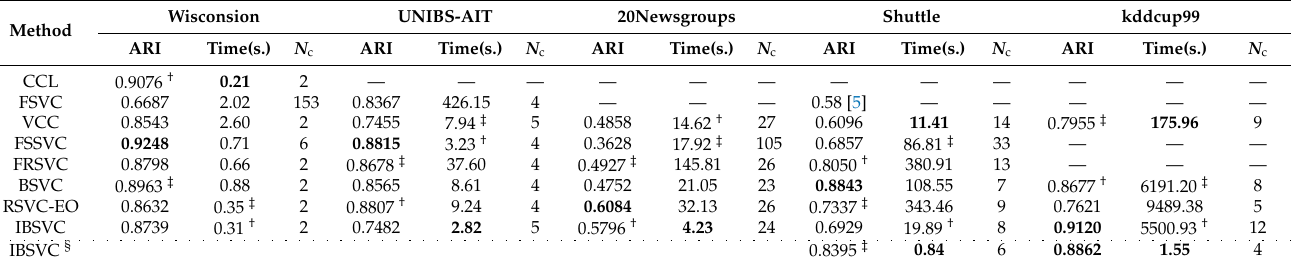
Table 4. Benchmark results on five typical data